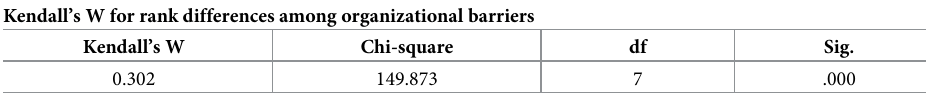
Table 5. Descriptive statistics (organizational barriers).